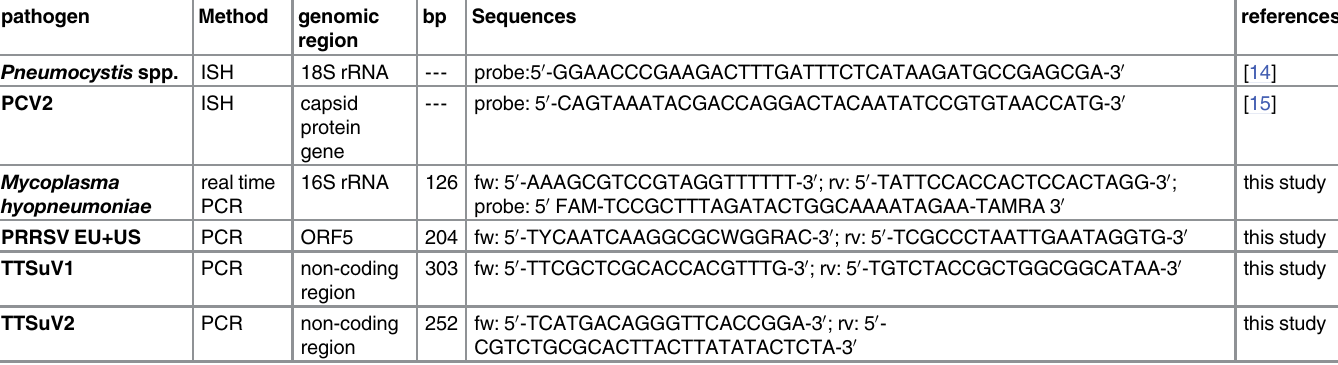
Table 1. Primer and probe sequences. bp = PCR product size in base pairs, fw = forward primer, rv = reverse primer.